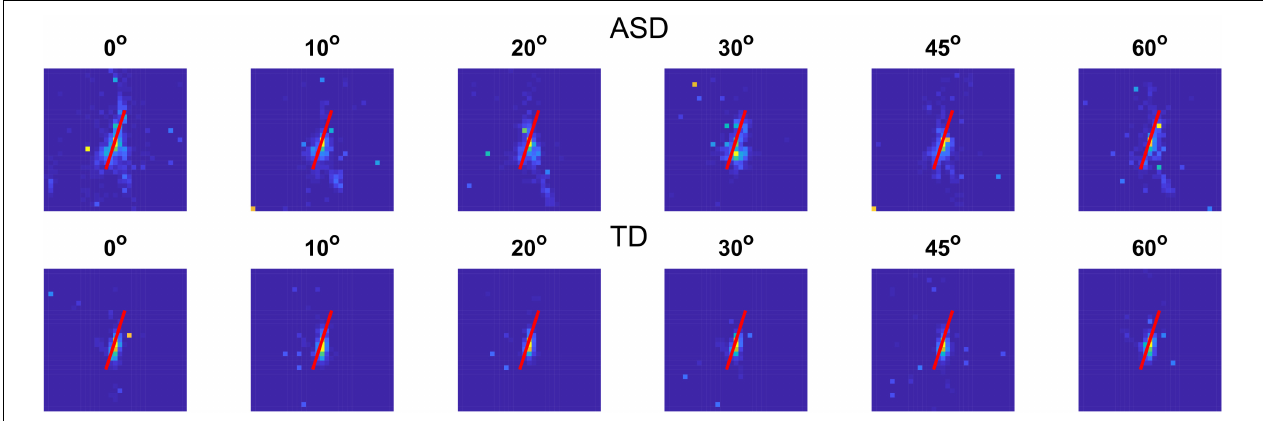
FIGURE 7 | Histogram of the gaze locations on a 31 × 31 grid for the two groups with different development at different noise levels. Gaze positions outside of the screen were excluded. The red line shows the contour